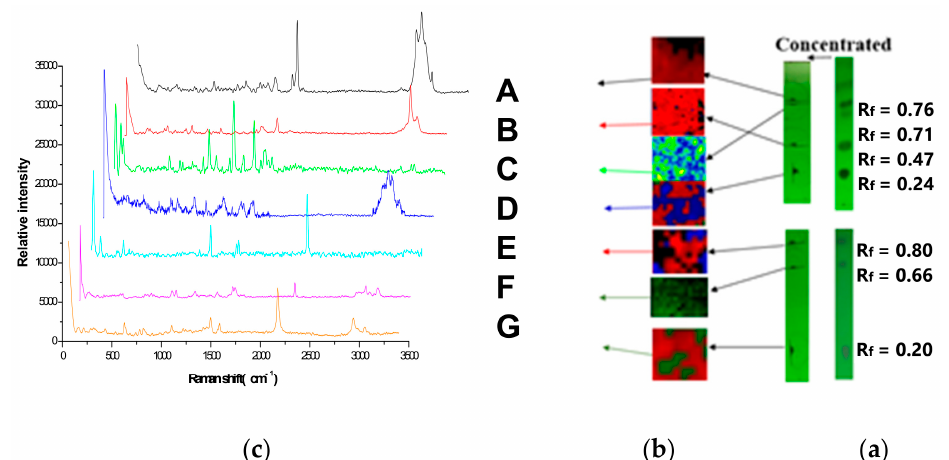
Figure 2. The Raman spectra of the seven pesticides in mixture by TLC-RIM. (( a – c ): The TLC, Raman